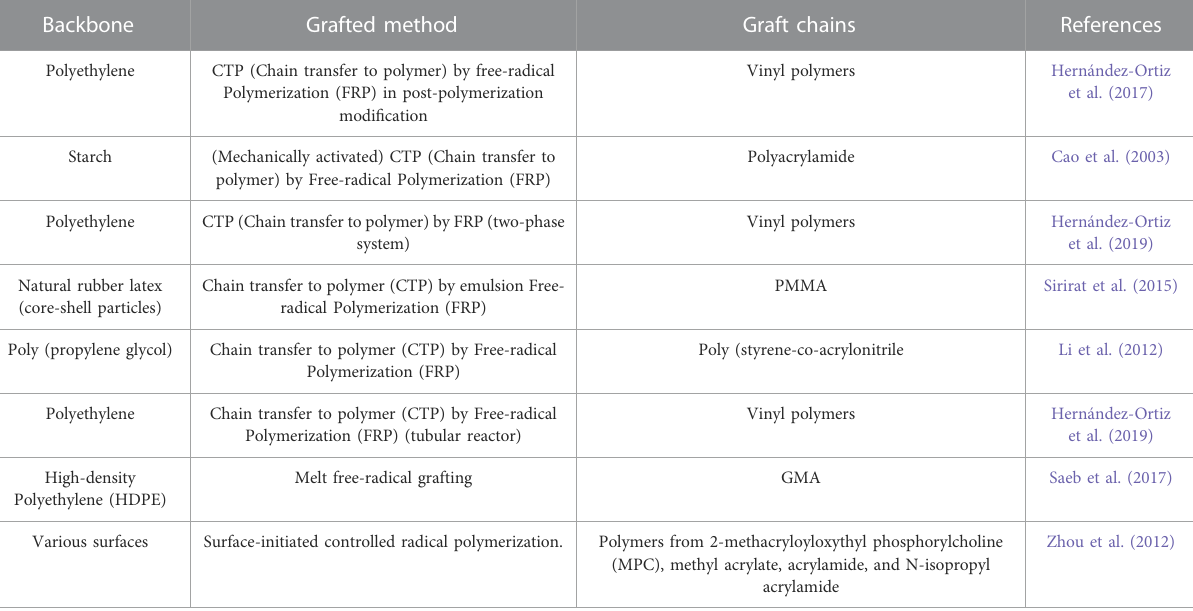
TABLE 1 Some examples of grafted polymers.